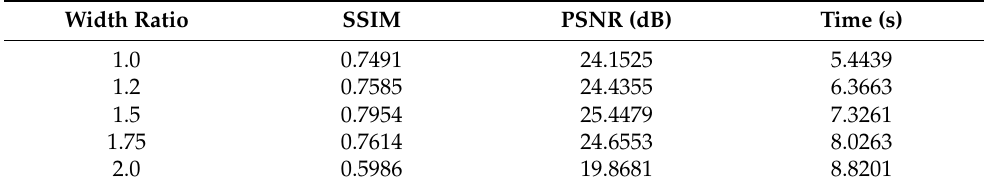
Table 2. Performances of proposed method according to the size of the neighboring blocks for outdoor pictures (Mozart